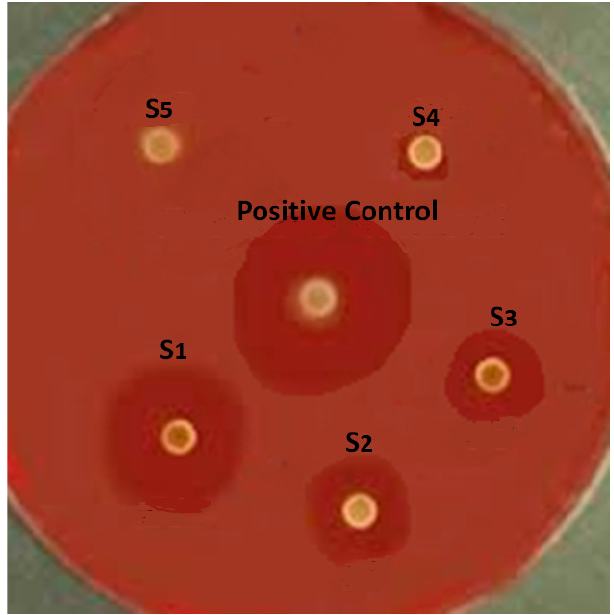
Figure 2. Mean growth inhibition zone of curcumin nanoparticle and control antibiotic in disk diffusion test.